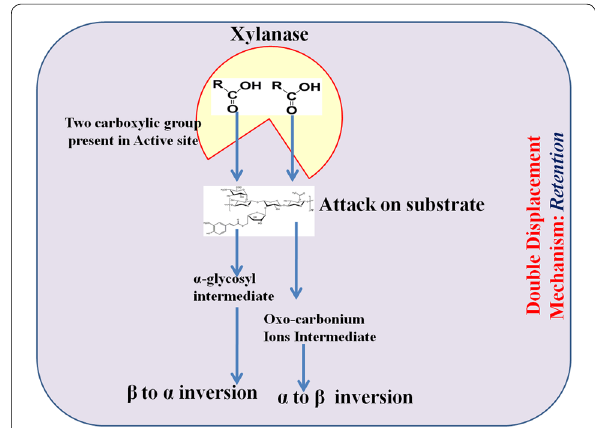
Fig. 2 Mode of action of xylanase: retention